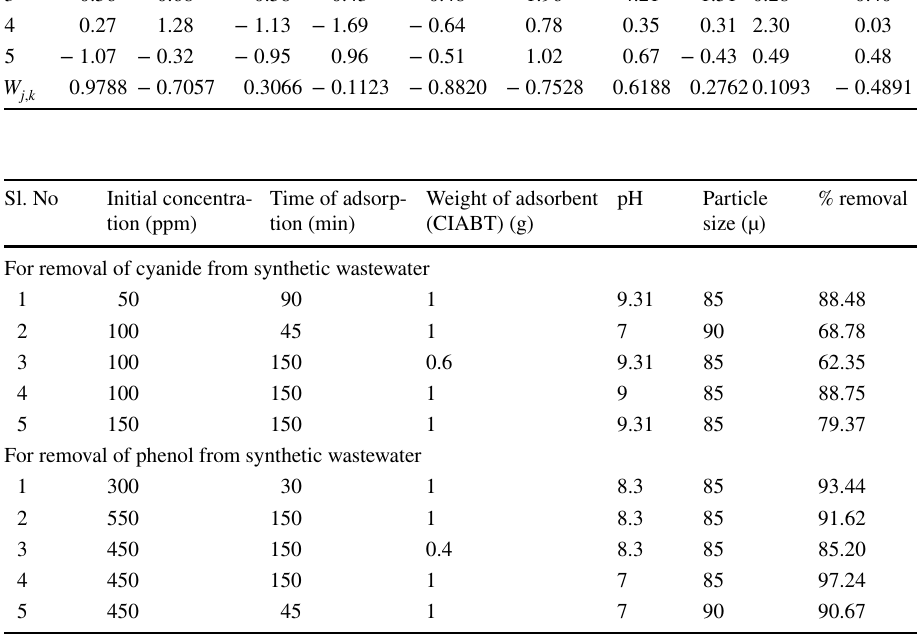
parameters for neural network correlations ( i = 5, j = 10, k = 1) for phenol removal